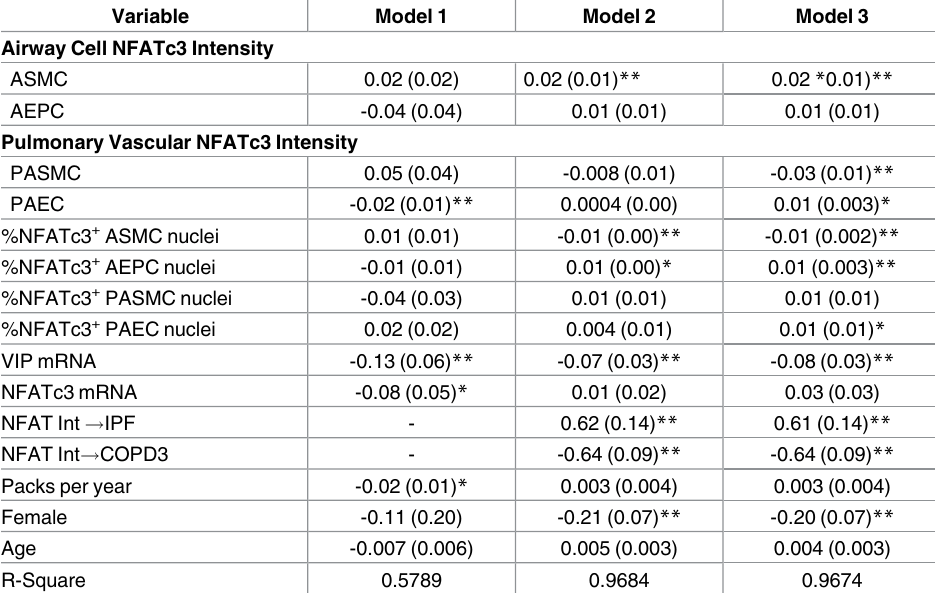
Table 2. FEV1/FVC by Intensity of NFATc3 and RNA.